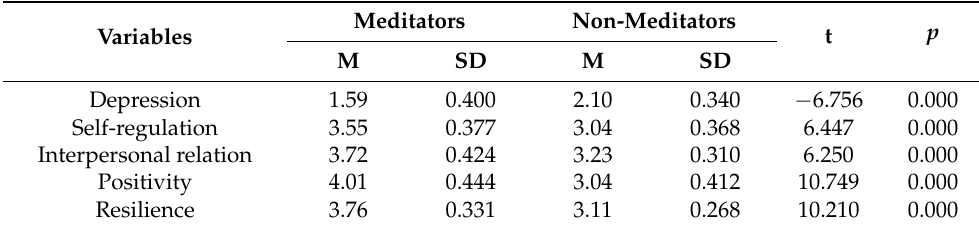
Table 3. Descriptives for outcomes of meditators and